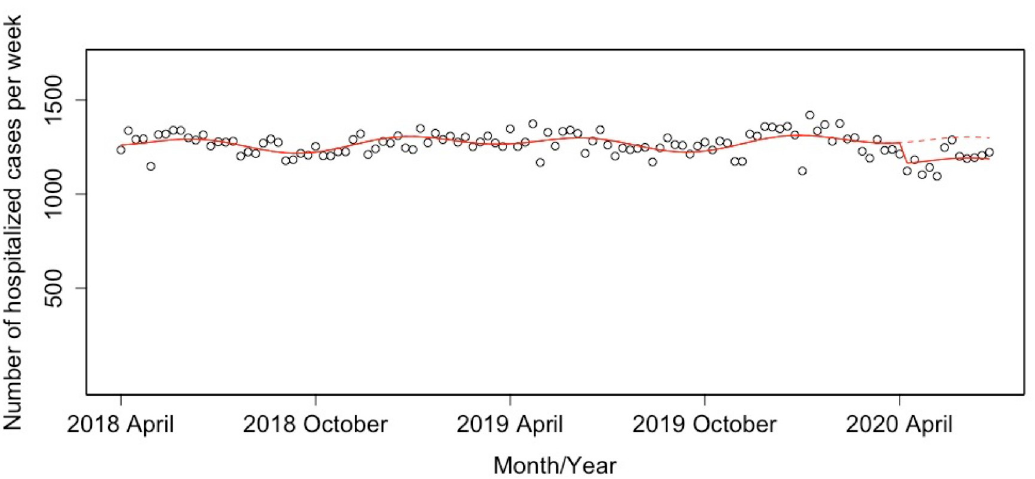
Fig 3. Interrupted time series analysis for the weekly number of dependent group inpatients with ischemic stroke between April 1 2018 and June 27 2020. Solid lines indicate the predicted trend based on a model, and dashed lines indicate the predicted trend based on a model in the scenario without the state of